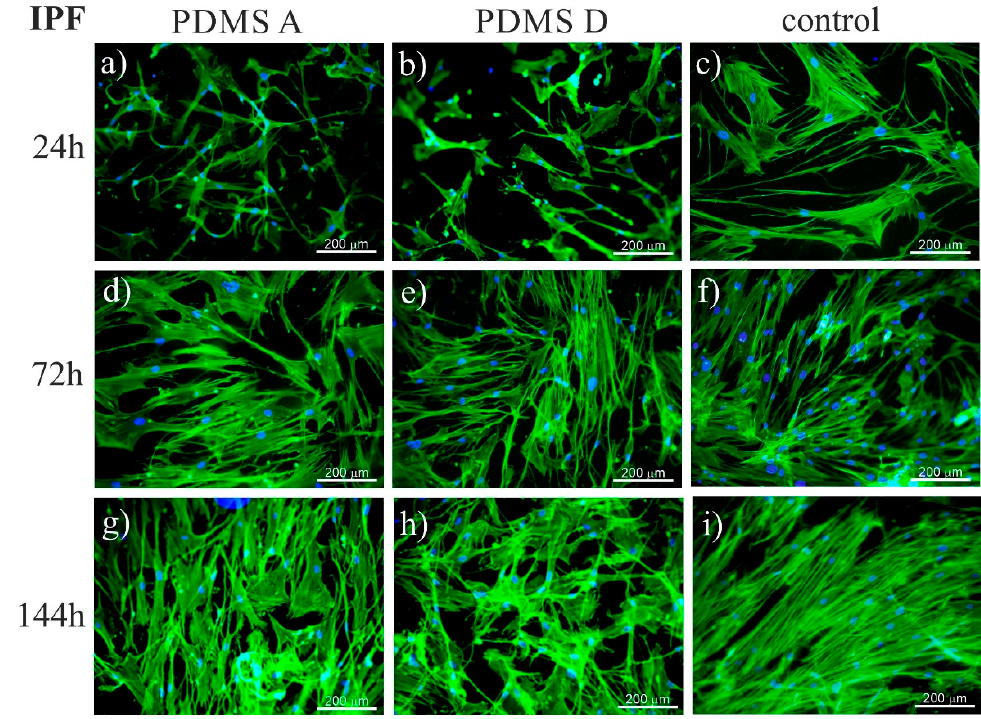
Figure 3. Fluorescence micrographs of the actin cytoskeleton (green) and nuclei (blue), recorded for IPF-derived fibroblasts cultured for 24 ( a – c ), 72 ( d – f ), and 144h ( g – i ) on PDMS A ( a , d , g ), PDMS D ( b , e , h ), and control samples (glass, ( c , f , i )).